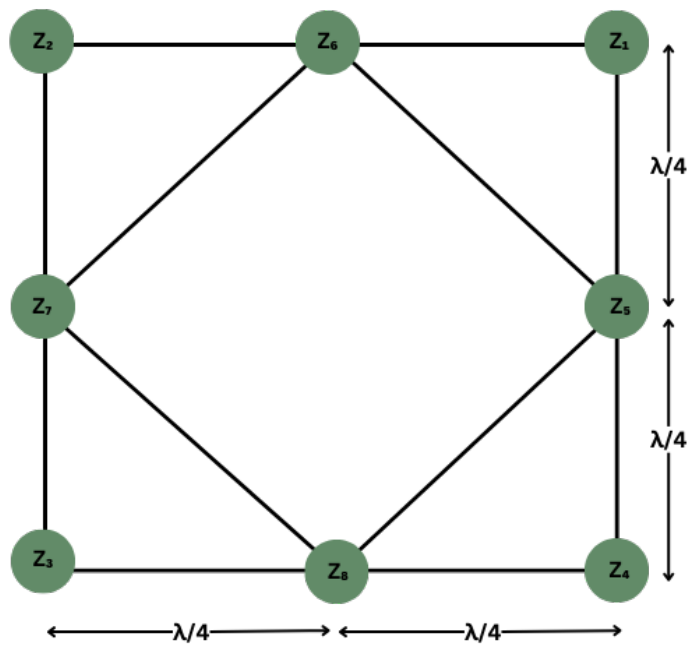
Figure 5. Proposed eight-element dipole antenna.